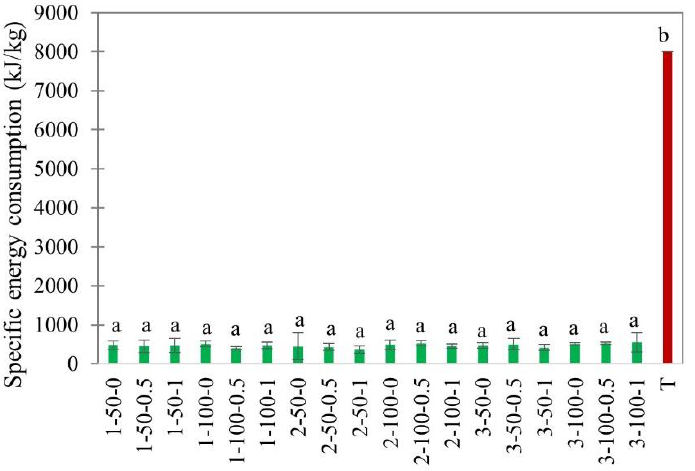
Figure 8. Specific energy consumption of EHD (marked in green and labeled as thickness-slice load density-airflow) and hot air-dried (marked in red as T) apple slices. Different lower-case letters indicate statistically significant differences ( p < 0.05).